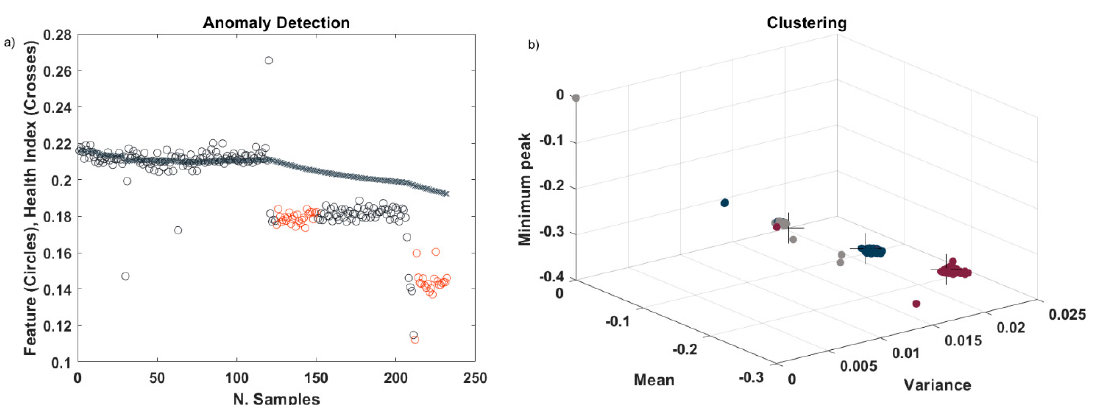
Figure 9. ( a ) Anomaly detection. ( b ) Autonomous data partitioning results.